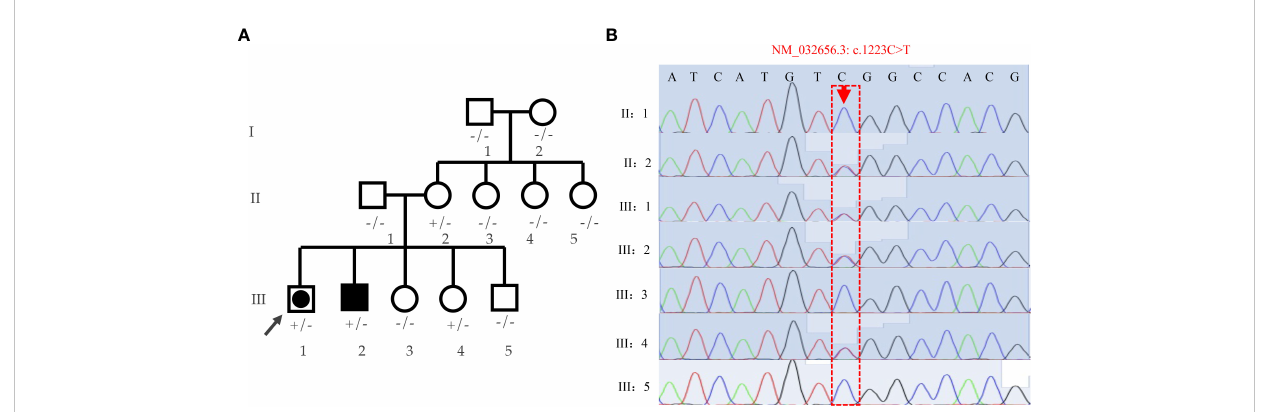
FIGURE 3 Analyses of the family pedigree with two cases affected by 46,XY DSD. (A) Family pedigree. Closed symbols represent affected individuals. The affected male (46, XY males) is indicated by a closed square and the affected individual raised as female (46,XY females) is shown by a large, closed circle within a square. Whole-exome was performed on the proband (indicated by black arrow), and Sanger sequencing were veri fi ed on all family members; genotypes are labeled on the chart. +/- heterozygous state; -/- homozygous state for wild-type allele. (B) Veri fi cation of the S408L mutation by means of Sanger sequencing in the pedigree.